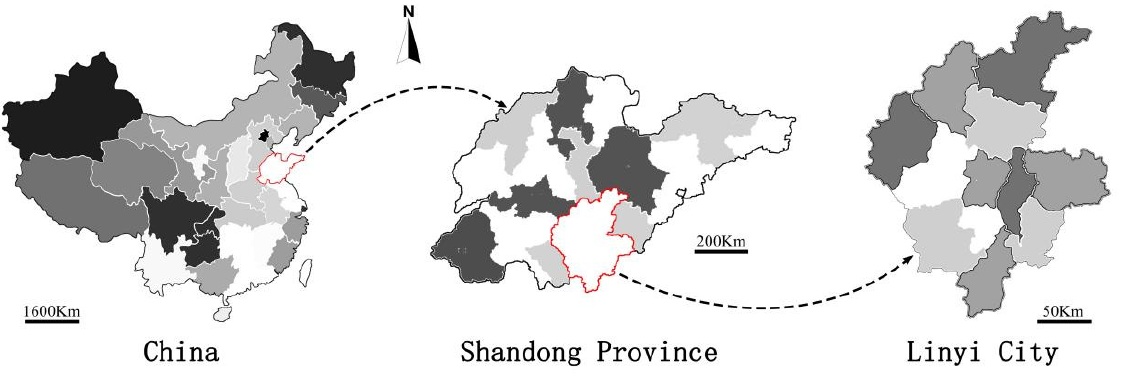
Figure 2. Location of Linyi.